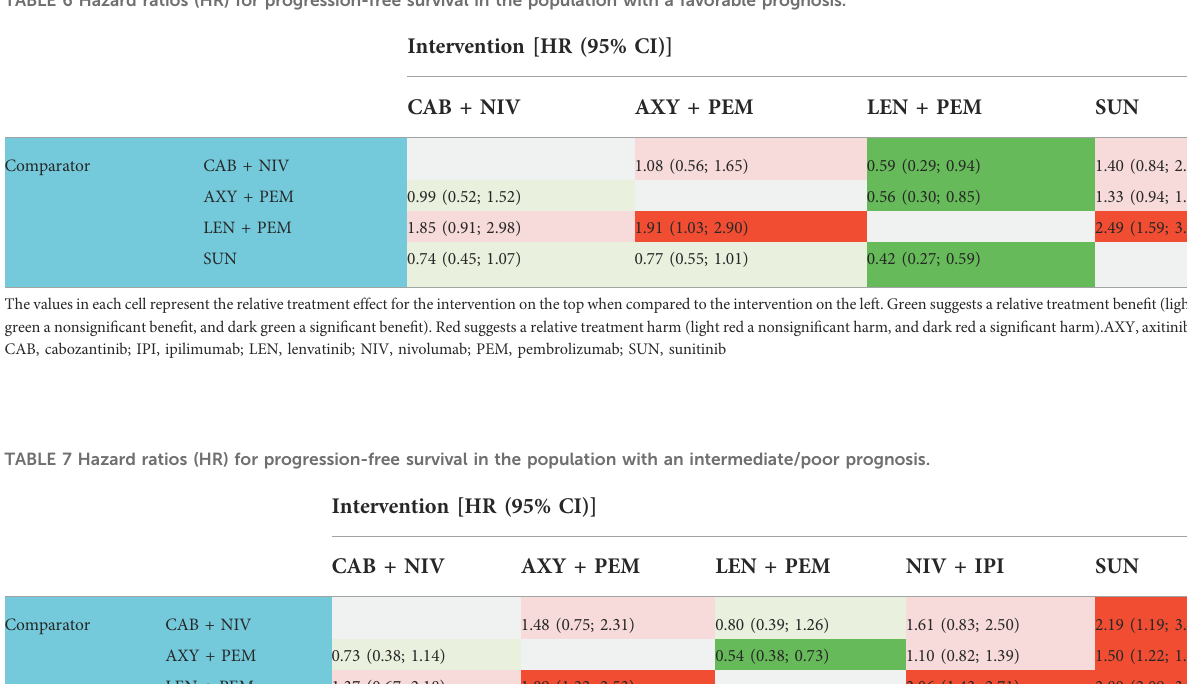
TABLE 6 Hazard ratios (HR) for progression-free survival in the population with a favorable prognosis.